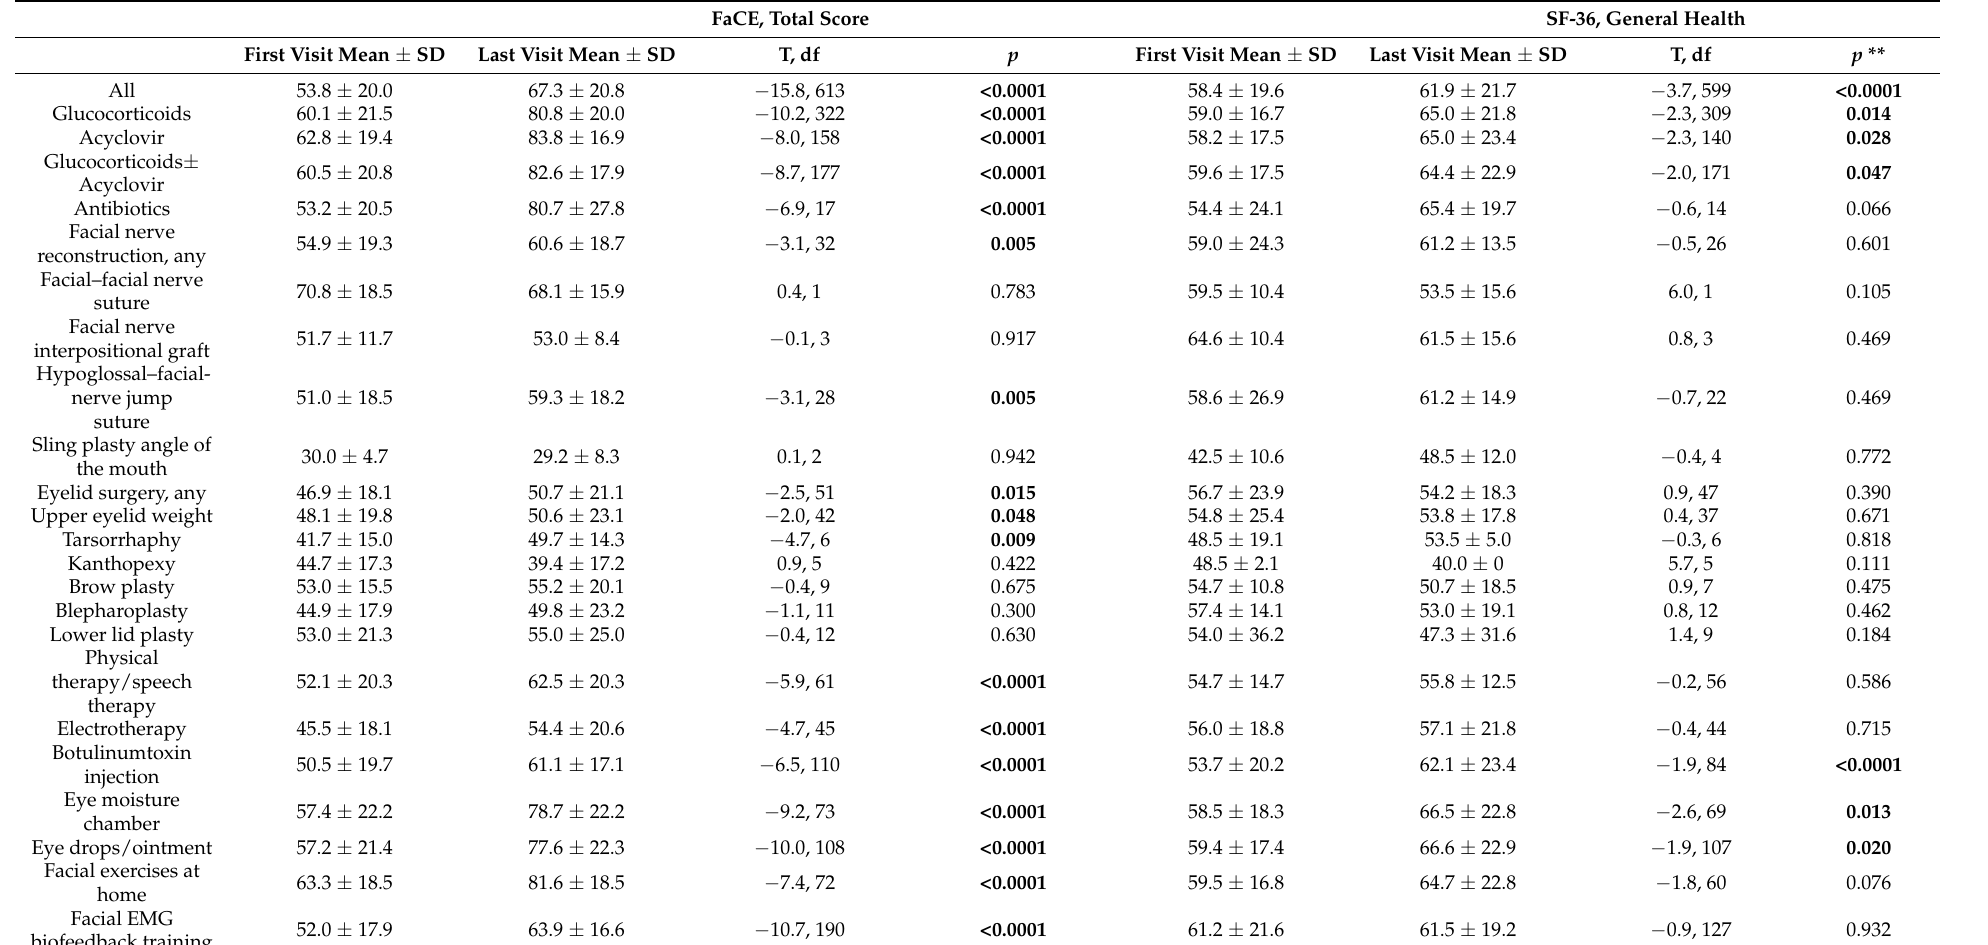
Table 7. Comparison of outcome measures using FaCE (total score) and SF-36 (general health subdomain) between first and last visits *. FaCE, Total